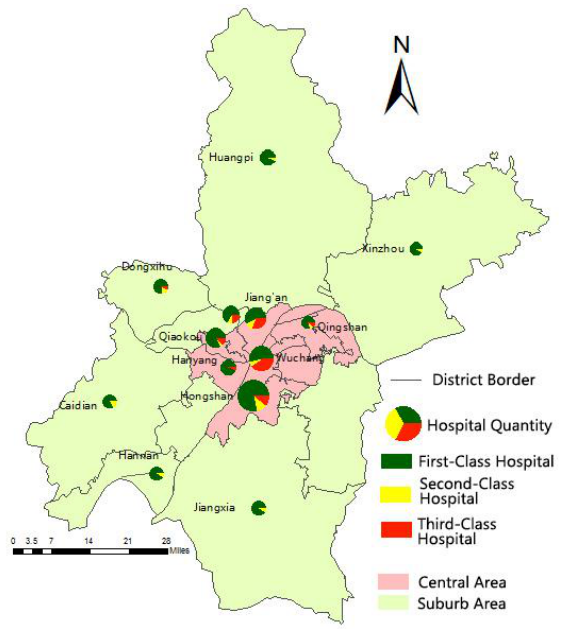
Figure 2. Wuhan hospital distribution.